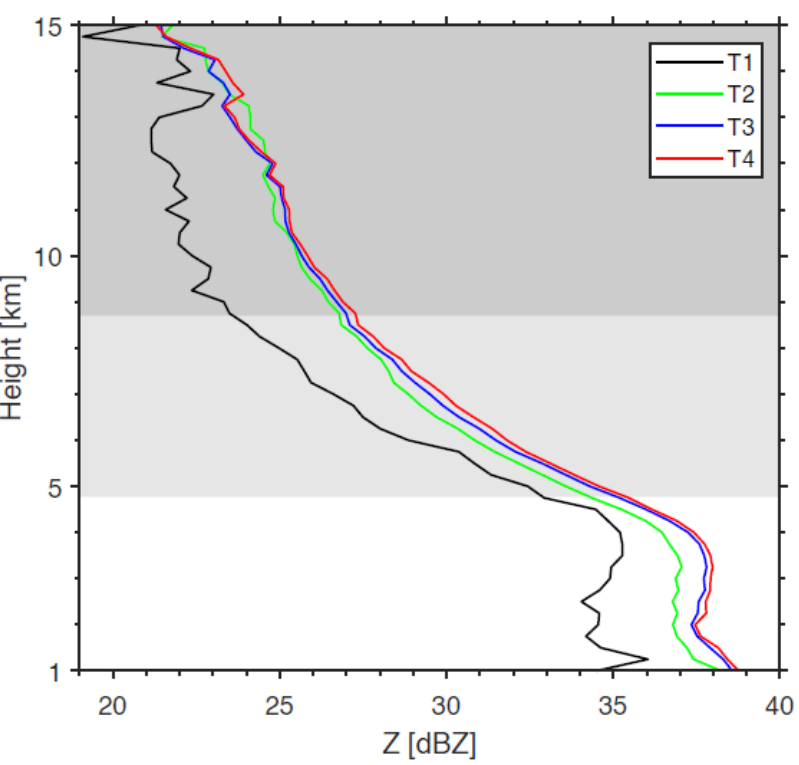
Figure 7. Average reflectivity profiles (dBZ) as a function of the lightning density categories T1 (<0.1 flash km −2 year −1 ; black line); T2 (between 0.1 and 2.8 flash km −2 year −1 ; green line); T3 (between 2.8 and 6.8 flash km −2 year −1 ; blue line); and T4 (above 6.8 flash km −2 year −1 ; red line). The regions highlighted in shades of gray indicate the microphysical layers: warm (white), mixed (light gray) and glacial phase (dark gray).